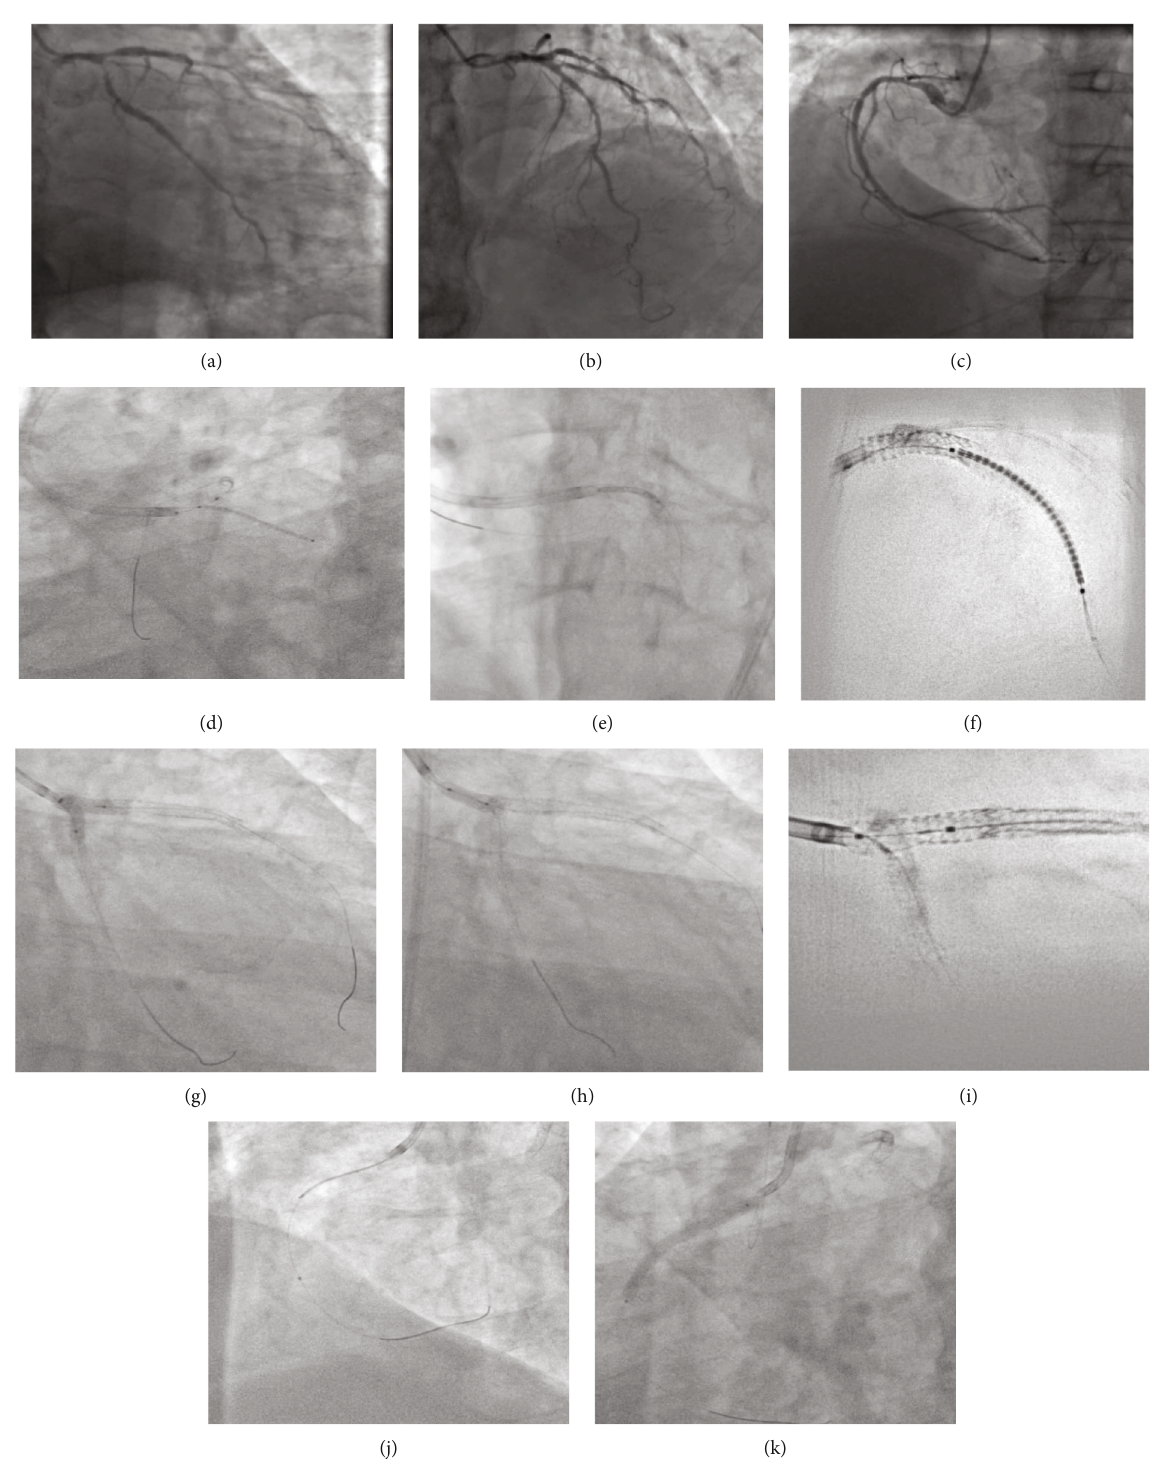
Figure 1: (a) Medina 0,1,1 disease. (b) Signi fi cant disease in proximal-mid LAD. (c) RCA proximal-mid disease. (d) Ostial LCX stent. (e) Sepal wire technique for ostial LMCA stent. (f) CLEARstent image of LAD stent. (g) FKBI (h) POT. (i) CLEARstent of bifurcation. (j) IVUS evaluation of RCA disease. (k) Ostial RCA